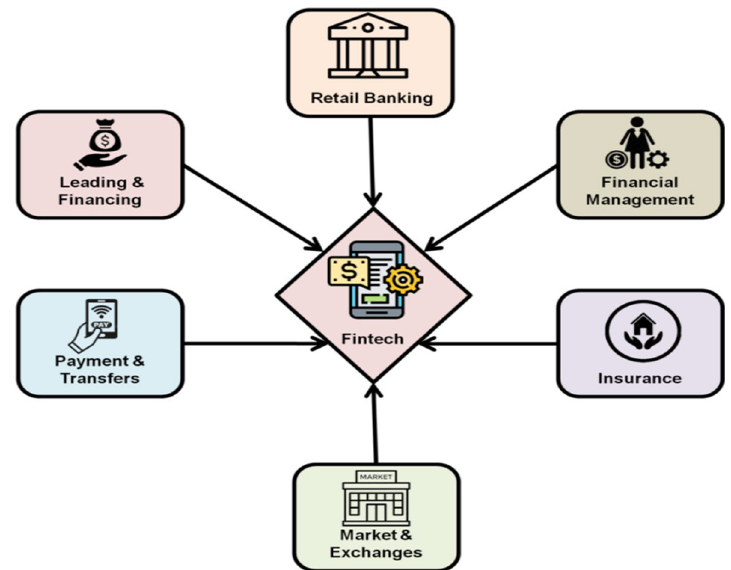
Fig. 1 General representation of financial technology